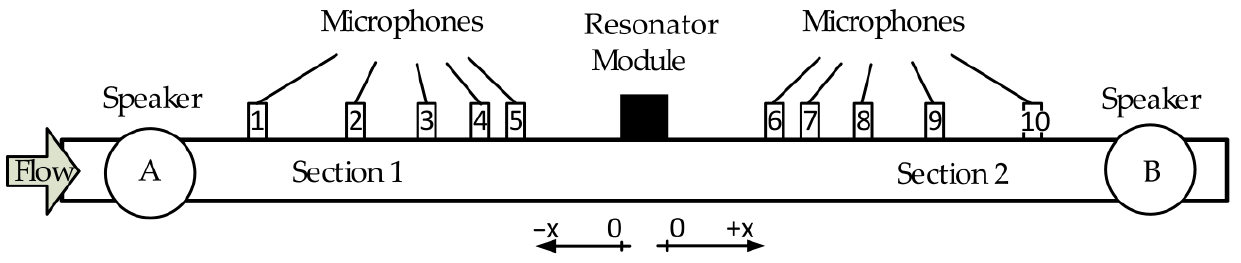
Figure 2. Schematic view of the DUCT − R test rig.